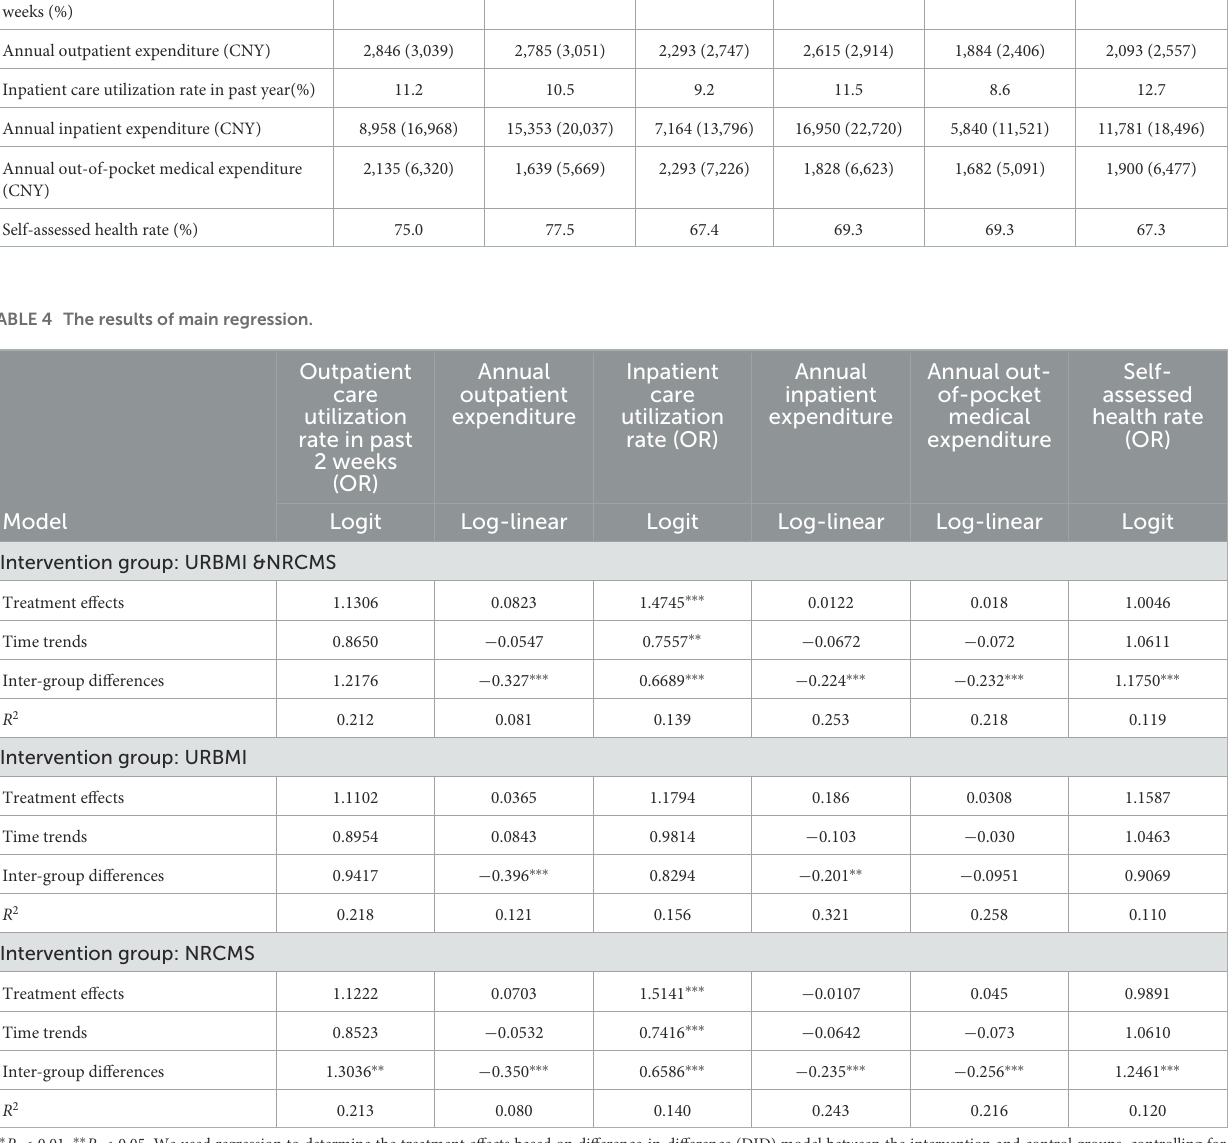
UEBMI URBMI Before After Before After Before After integration integration integration integration integration integration